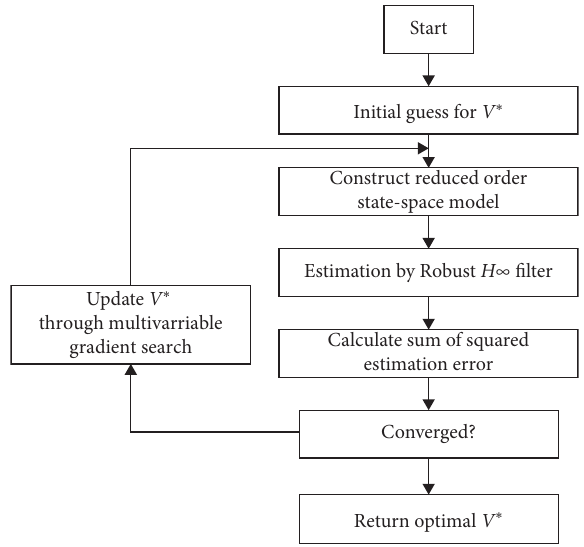
Figure 1: Flowchart of V ∗ iterative search.